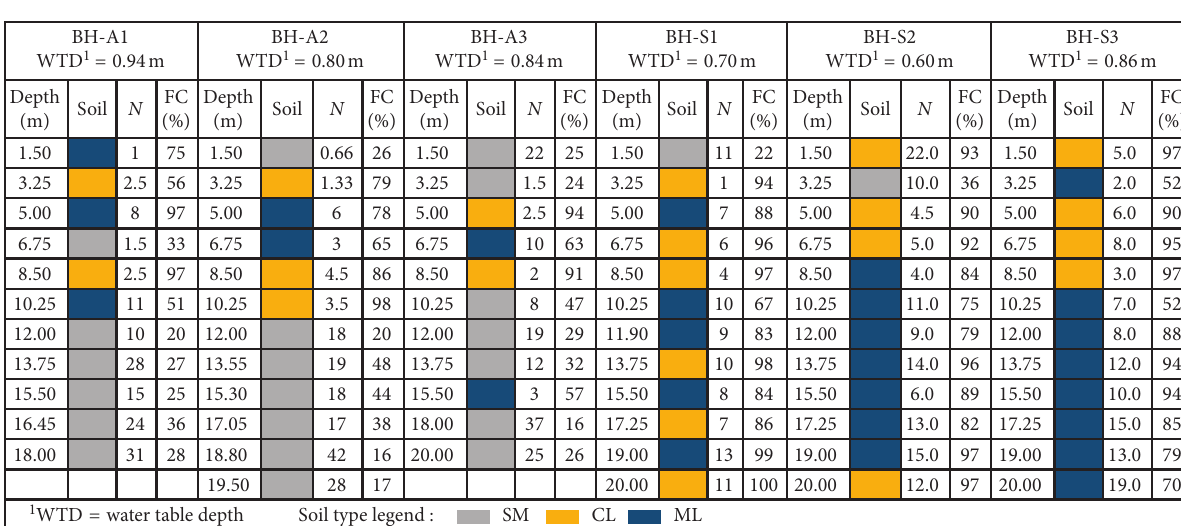
Figure 3: Investigation results of